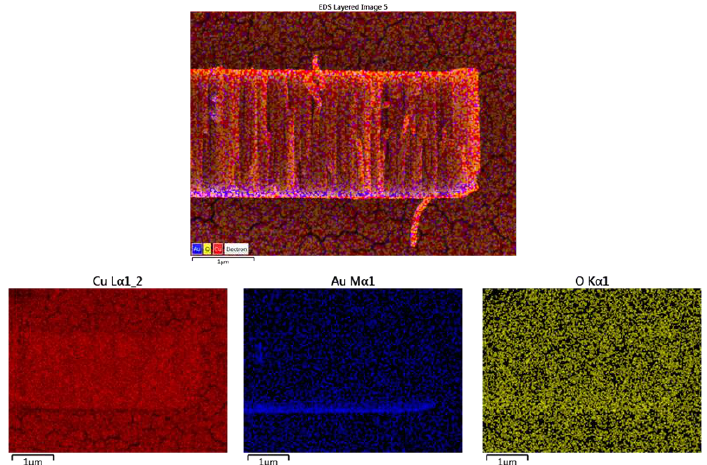
Figure 3. Cross-section EDX analysis of Au-CuNC.